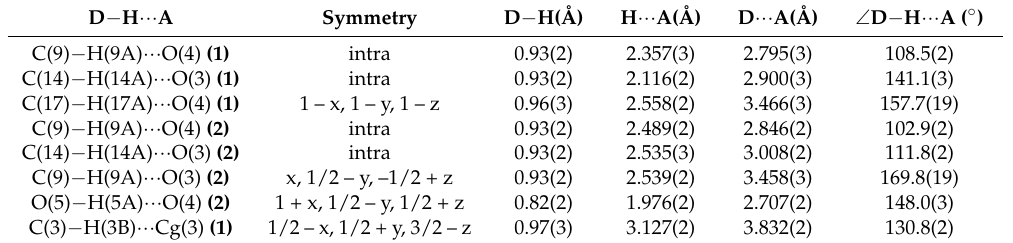
Cg(3) ring denotes the phenyl ring of compound 1: C(10)–C(15). Table 3. Aromatic-aromatic interactions of 1 and 2.